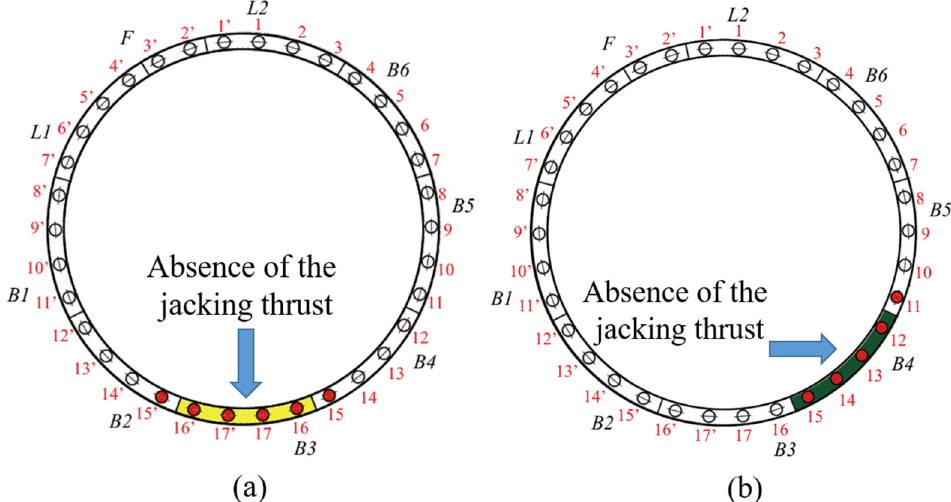
Figure 3. Steps of jack jacking in synchronous propulsion and assembly mode: ( a ) The working condition of the jack when the first segment is assembled; ( b ) The working condition of the jack when the second segment is assembled.